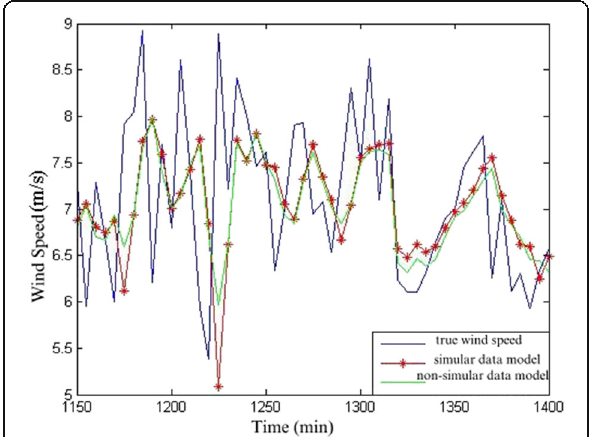
Fig. 4. The forecasting results with and without similar